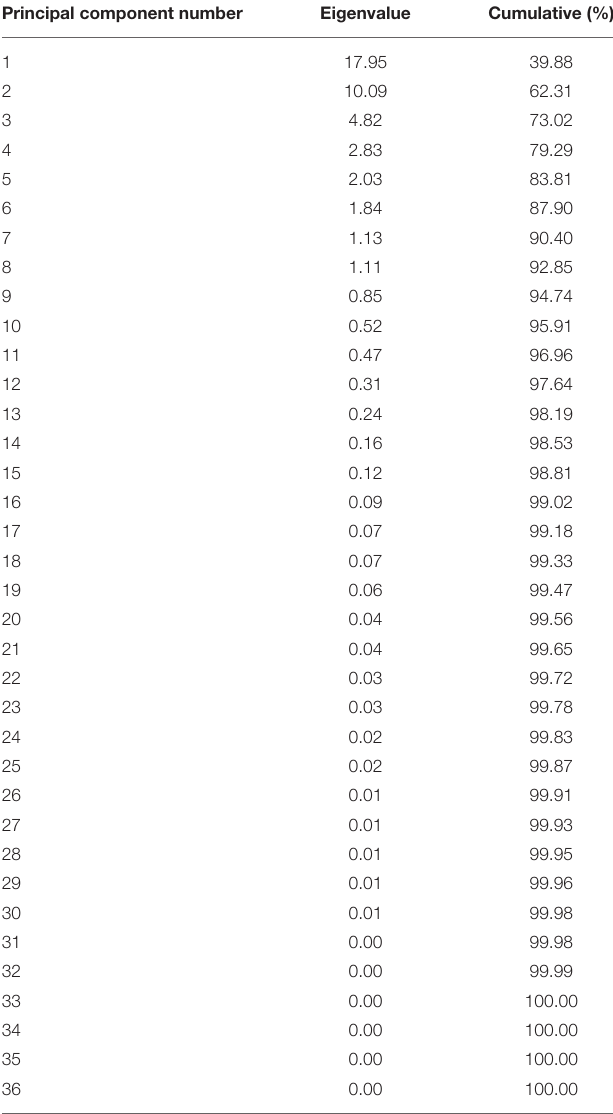
TABLE 2 | Eigenvalue and cumulative of plant hormone